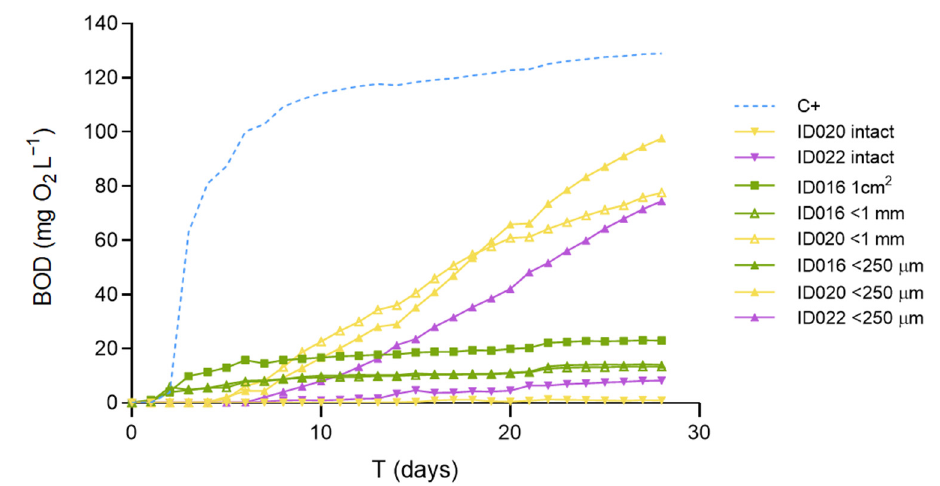
Figure 2. Effect of particle size and shape on the marine biodegradation of PHB (ID020) and PHBV (ID022) pellets and a home-compostable bag (ID015). The resins consisted of 3 mm pellets that were tested intact and after micronization down to <1 mm and <250 µm. The bag was tested, cut into 1 cm 2 pieces, and micronized. C+ is the positive control of PHB powder.